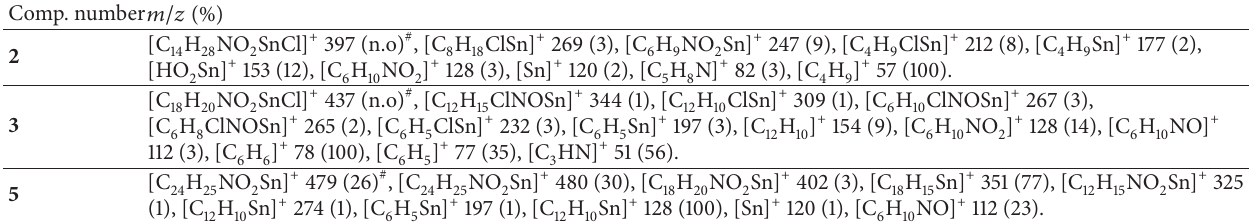
Table 6: Mass spectral data of organotin complexes 2 , 3, and 5